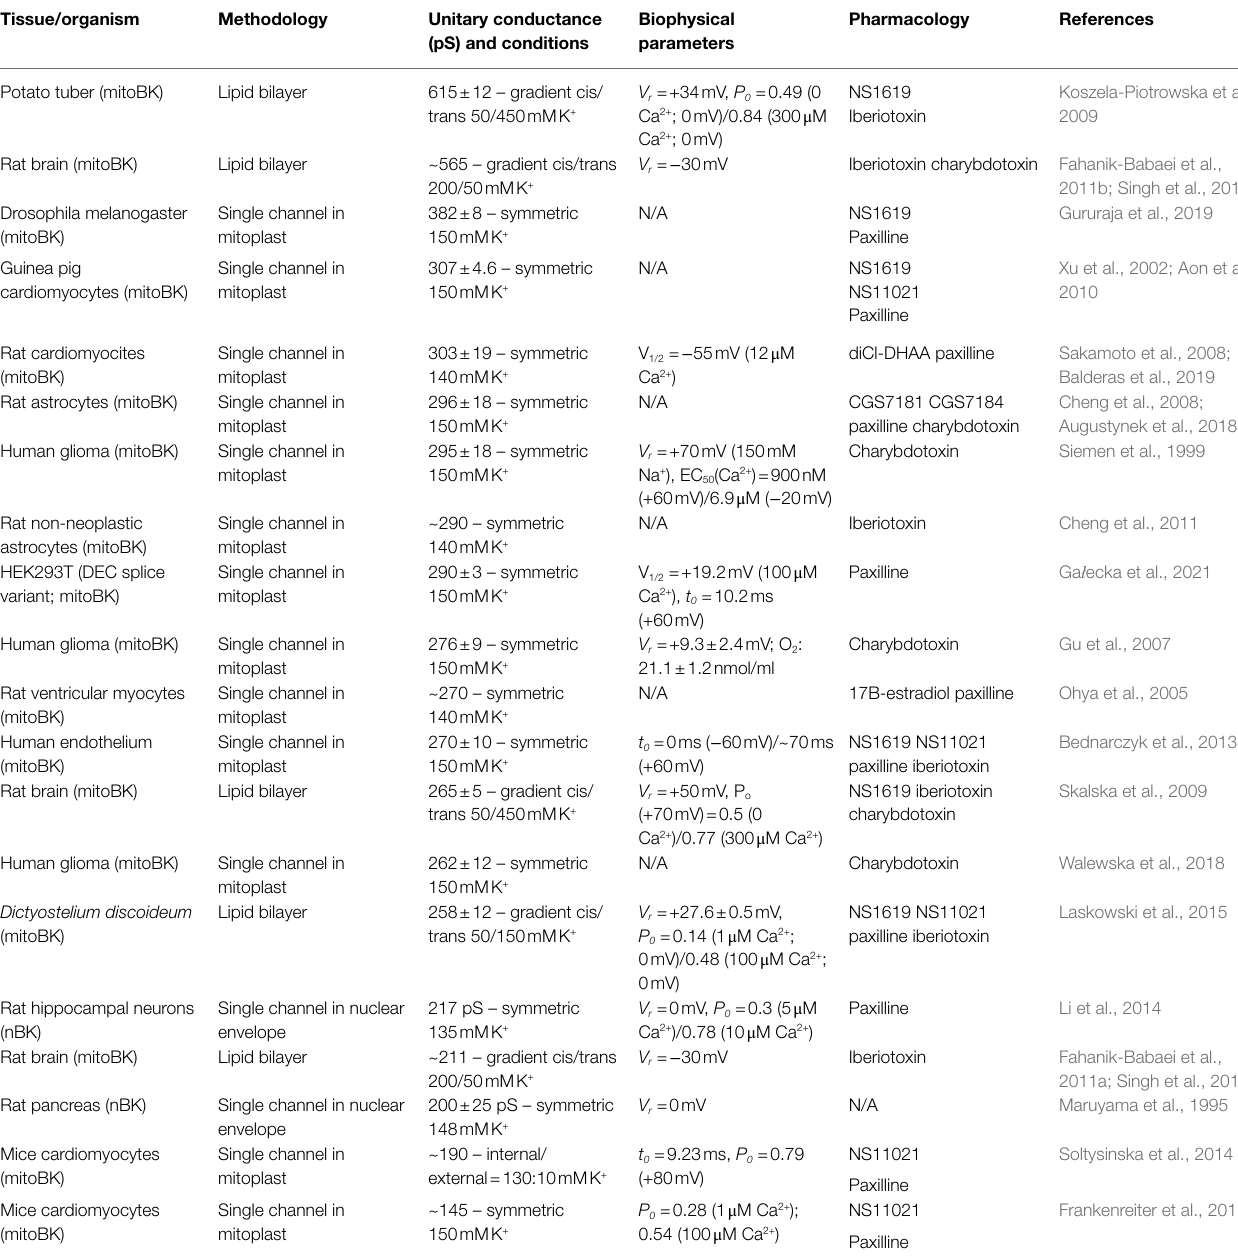
TABLE 1 | Biophysics and Pharmacology of mitoBK and